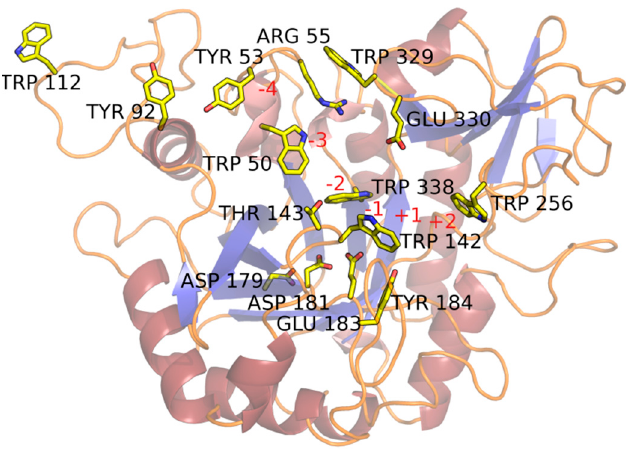
Figure 4. The substrate-binding site of St Chi40. Residues lining the substrate-binding cleft are shown and discussed in the text. Subsites are labelled red. Solvent molecules are not